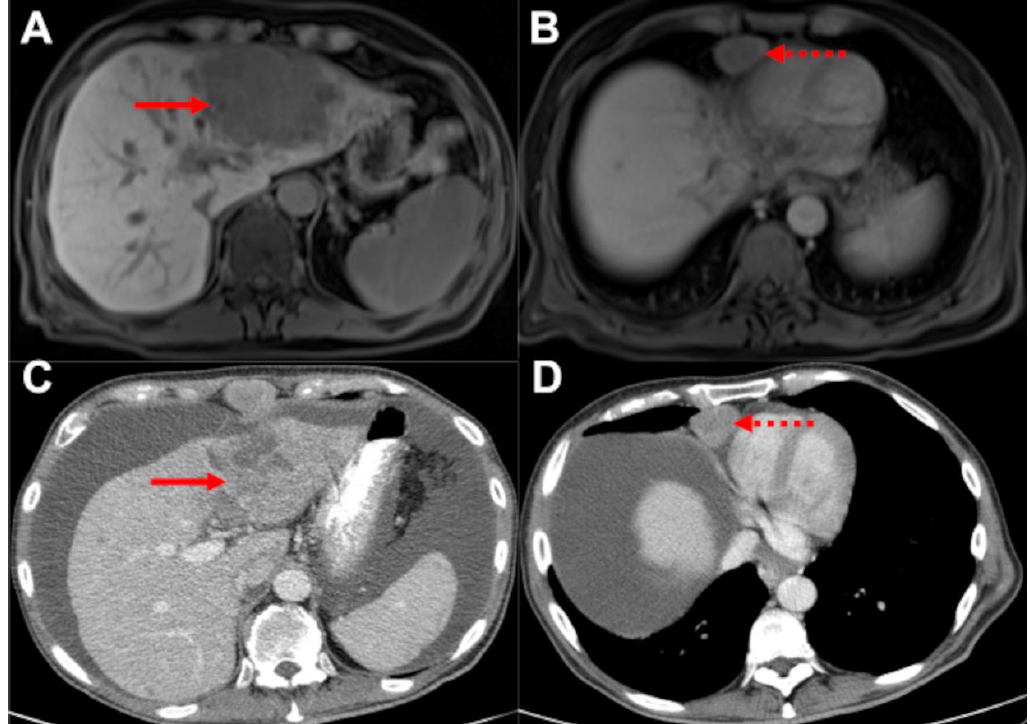
Figure 3. No change in management as EHD is present in both MRI and CT. ( A , B ): liver MRI, hepatobiliary phase, and axial plane. ( C , D ): abdomen and chest CT, soft tissue window, axial plane. Both MRI ( A , B ) and CT ( C , D ) show the HCC in liver segment II (solid arrows) and a cardiophrenic lymph node metastasis (dashed arrows). Therefore, palliative treatment was recommended, and additional CT staging did not result in a change in patient management. Paracentesis was performed between CT and MRI.